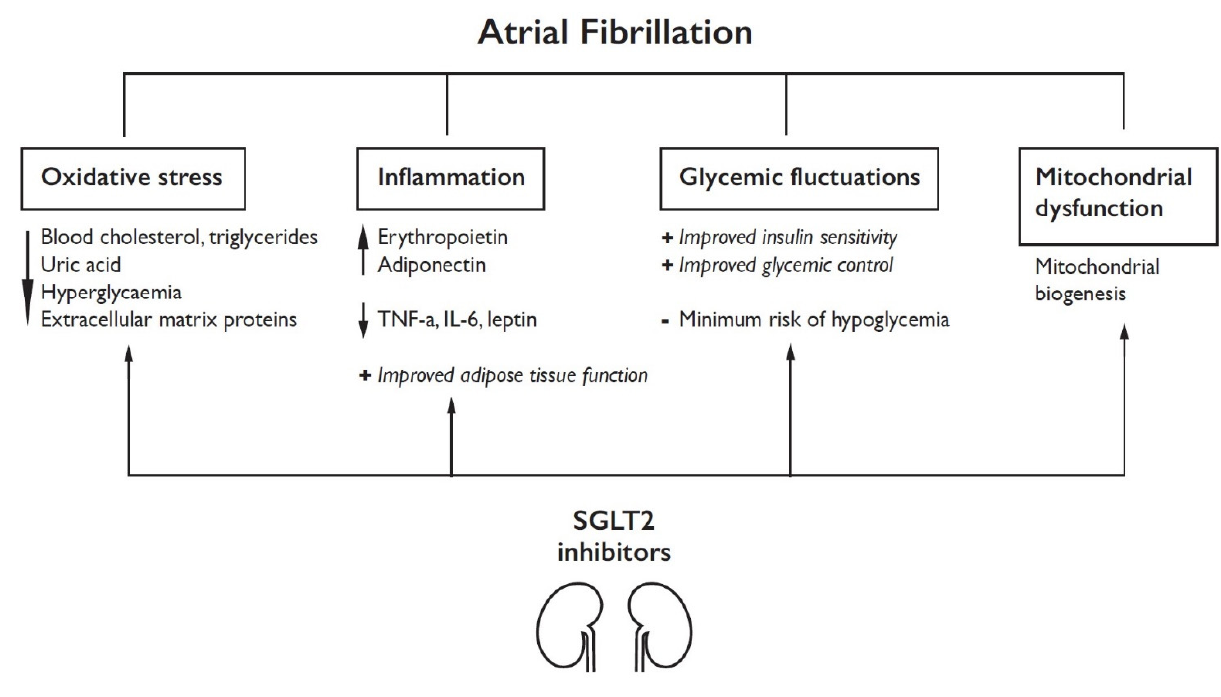
Figure 1. Protective mechanism of SGLT2 inhibition on atrial fibrillation. SGLT2: sodium-glucose cotransporter-2, TNF: tumor necrosis factor, IL: interleukin.